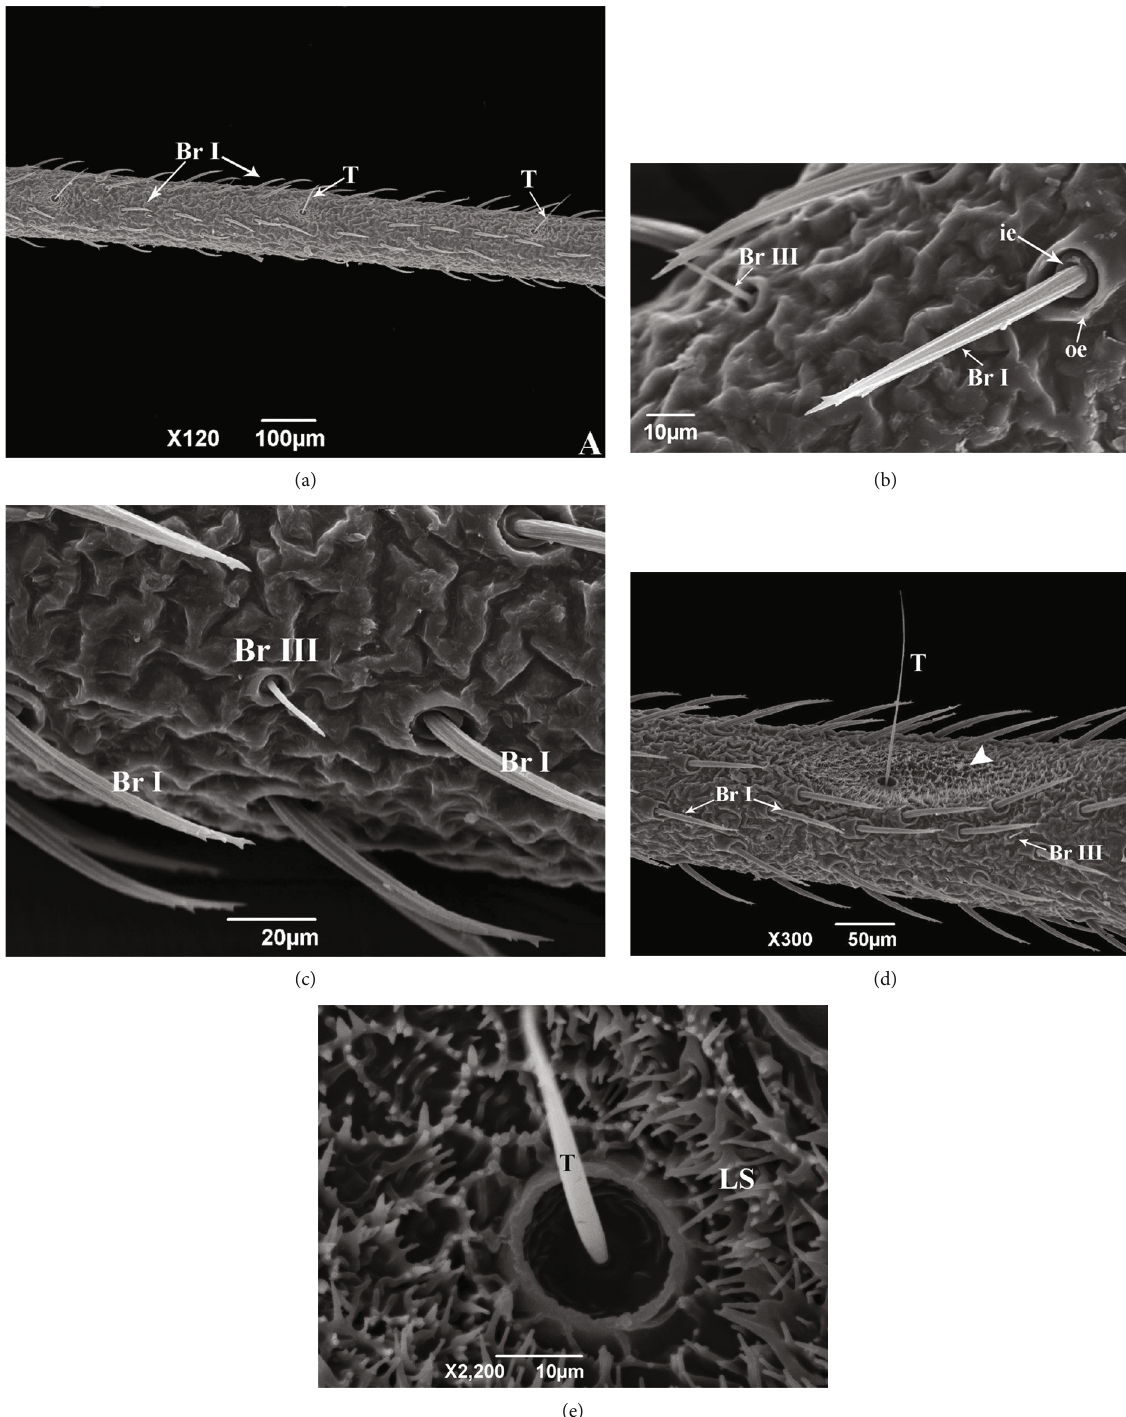
Figure 2: Scanning electron micrographs of the second antennal segment (S2) of R. brethesi . (a) Br I: bristles I; T: trichobothria. (b) Bristle I details. Br III: bristle III; ie: internal edge; oe: outer edge. (c) Br I: bristles I. Br III: bristle III. (d) Trichobothria sensilla (T) with a cuticular